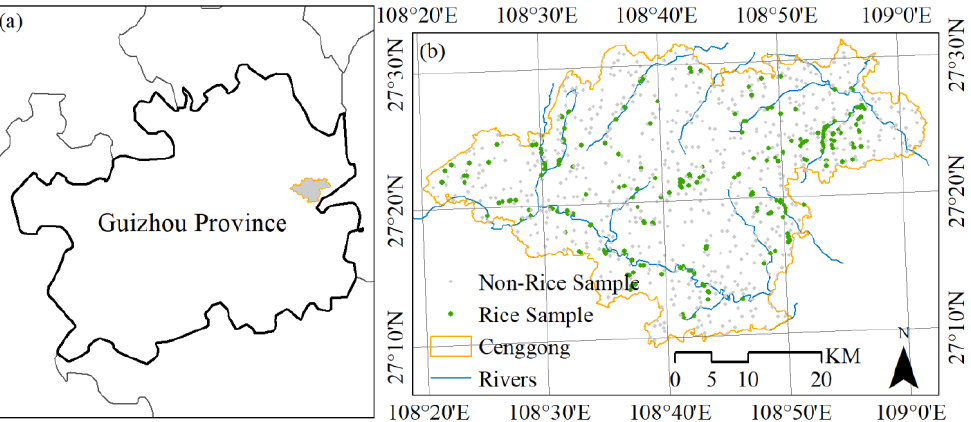
Figure 1. Maps of study area and sample points: ( a ) the yellow scope indicates the study area in Guizhou Province, China; and ( b ) non-rice and rice represent sample points for training and validating classifiers.